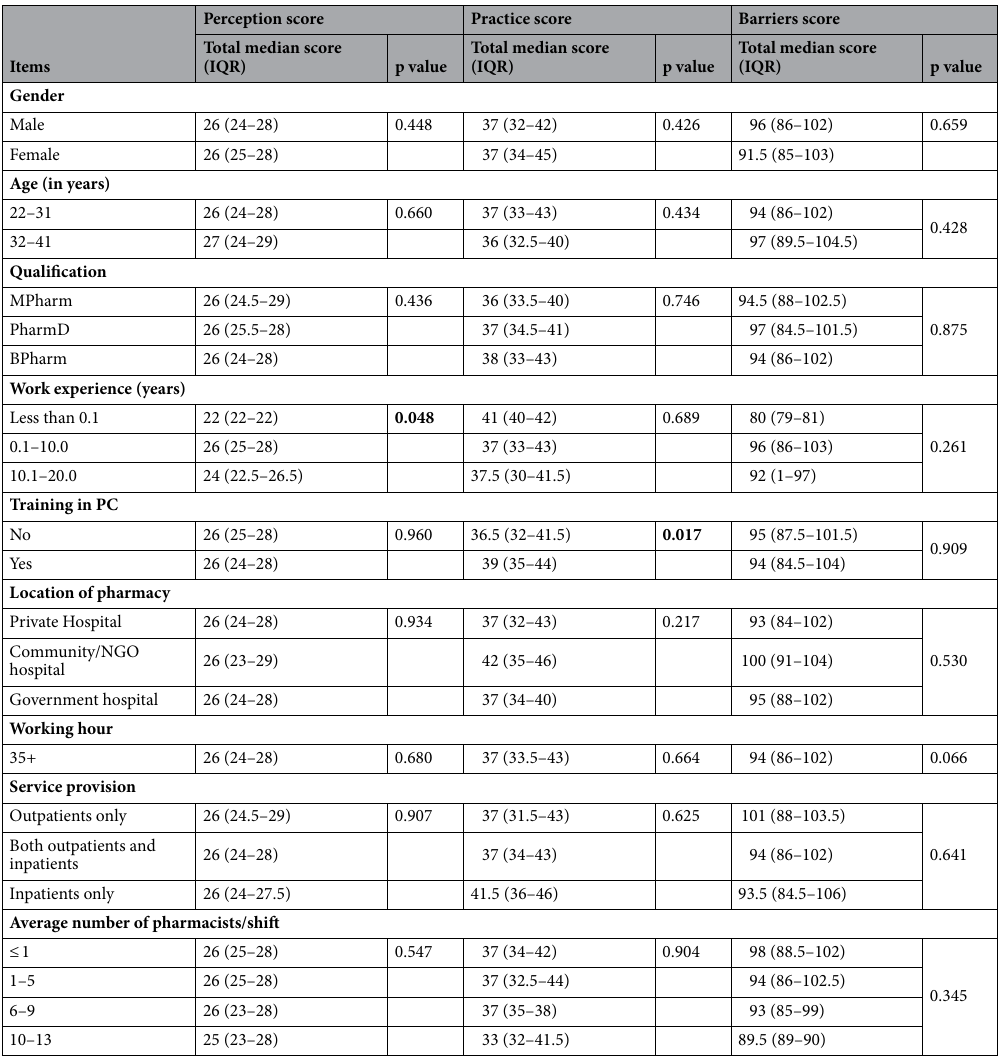
Table 8. Scores of perception, practice and barriers to pharmaceutical care among subgroups of respondents. IQR interquartile range (expressed as Q1–Q3). Mann–Whitney U test was used for dichotomous variables and the Kruskal Wallis test for variables with three or more than three responses. Significant values are in